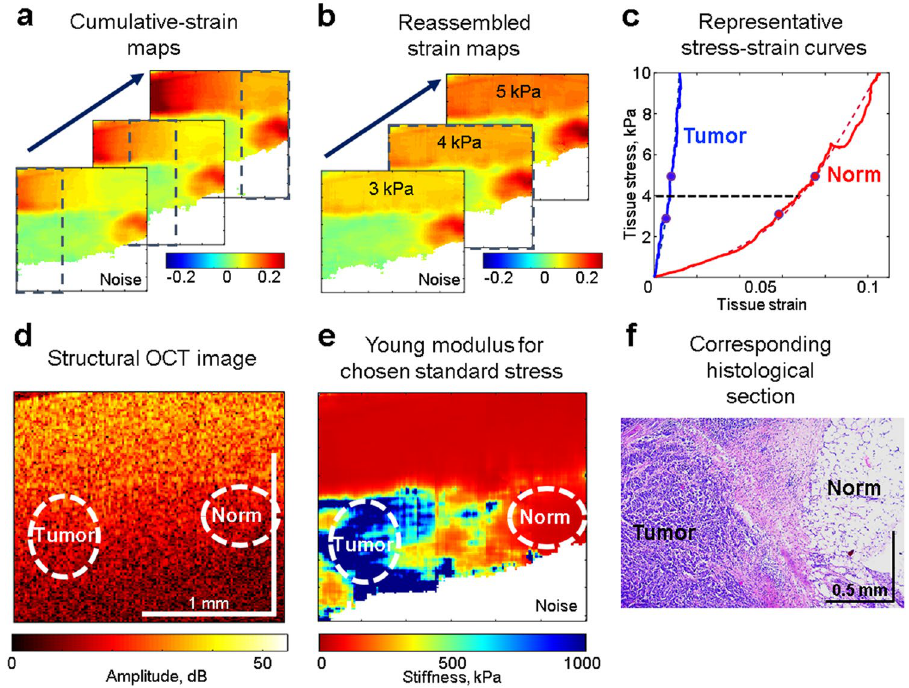
Figure 4. Schematically shown experimental OCE procedures for obtaining synthesized stiffness maps ensuring standardized pressure exerted on structurally/geometrically inhomogeneous breast tissue. ( a ) A series of initially calculated maps of cumulative strains that are essentially inhomogeneous within the reference silicone layer. ( b ) Reassembled (synthesized) maps of cumulative strains corresponding to the three pre-selected levels of pressure (3, 4 and 5 kPa) in the reference silicone layer. ( c ) Representative nonlinear stress–strain curves obtained for two regions essentially differering in stiffness (normal and tumorous region). The curves demonstrate that the local slope of the stress–strain curves (i.e. the Young’s modulus) may change several times even for apparently moderate strain ~ several percents. ( d ) Typical initial structural OCT scan. ( e ) Synthesized Young’s-modulus map corresponding to the standardized stress of 4 kPa in the reference silicone across the entire scan. ( f ) Histological section corresponding to the same